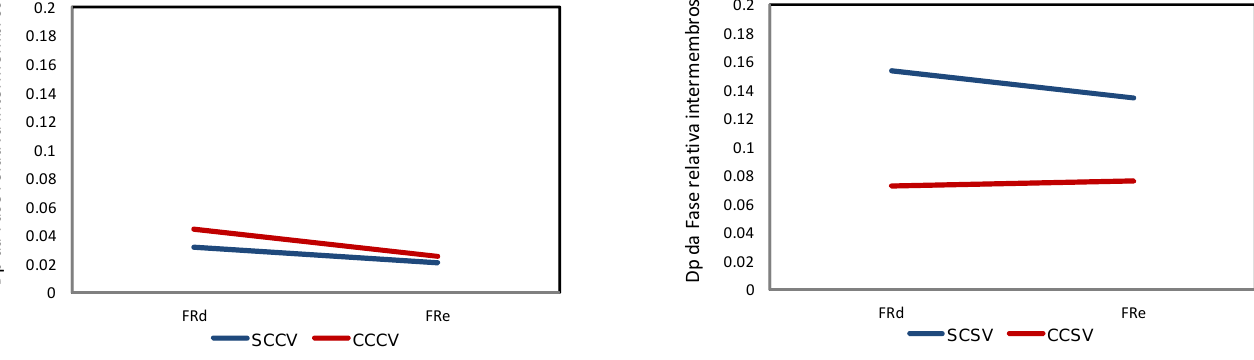
Figura 8. Desvio-padrão (Dp) da fase relativa intermembros nas condições experimentais com e sem o cão, mas com uso da visão (lado esquerdo) e com e sem o cão, mas sem o uso da visão (lado